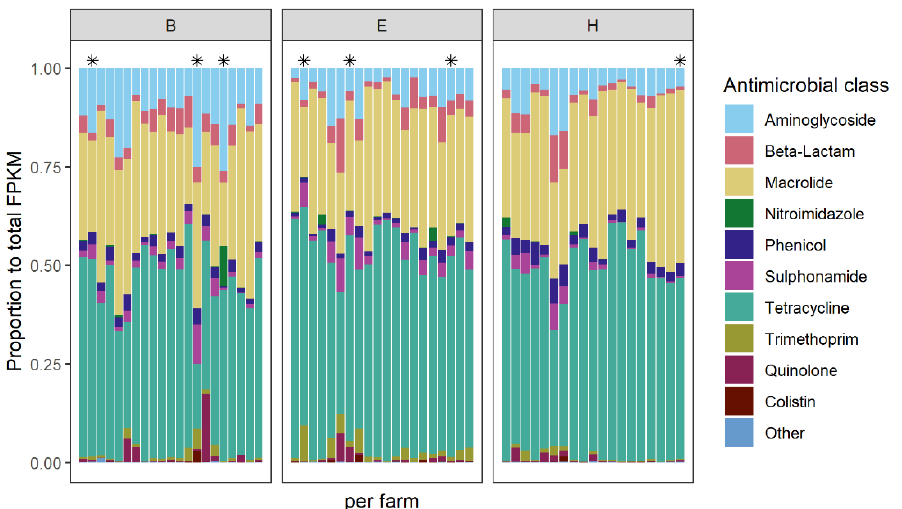
Figure 2. Relative abundance of antimicrobial (AMR) genes expressed as a proportion of total frag- ments per kilobase reference per million bacterial fragments (FPKM). Columns represent 60 samples from 60 farms from three countries (B: n = 21, E: n = 20, and H: n = 19). One additional farm was visited in country B due to incomplete questionnaire data in one of the farms, resulting in 21 samples in total. One sample in country H was removed due to errors during processing. The AMR genes were aggregated to antimicrobial classes. Seven farms where no antimicrobial use was reported in the sampled flock are indicated with an asterisk above the columns.